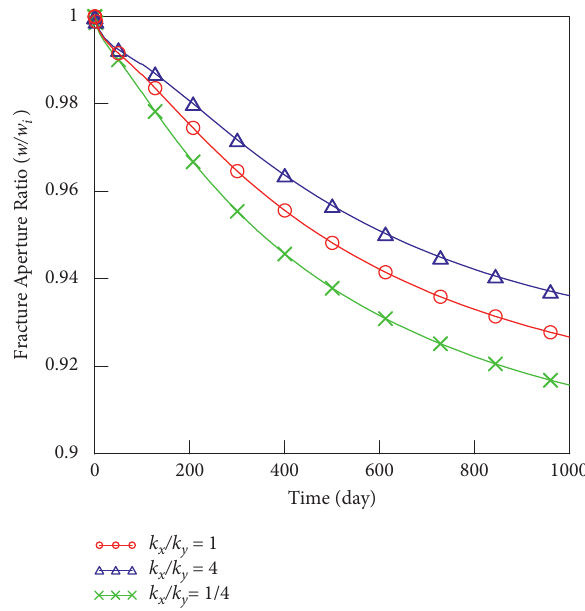
Figure 19: Fracture aperture history for fracture